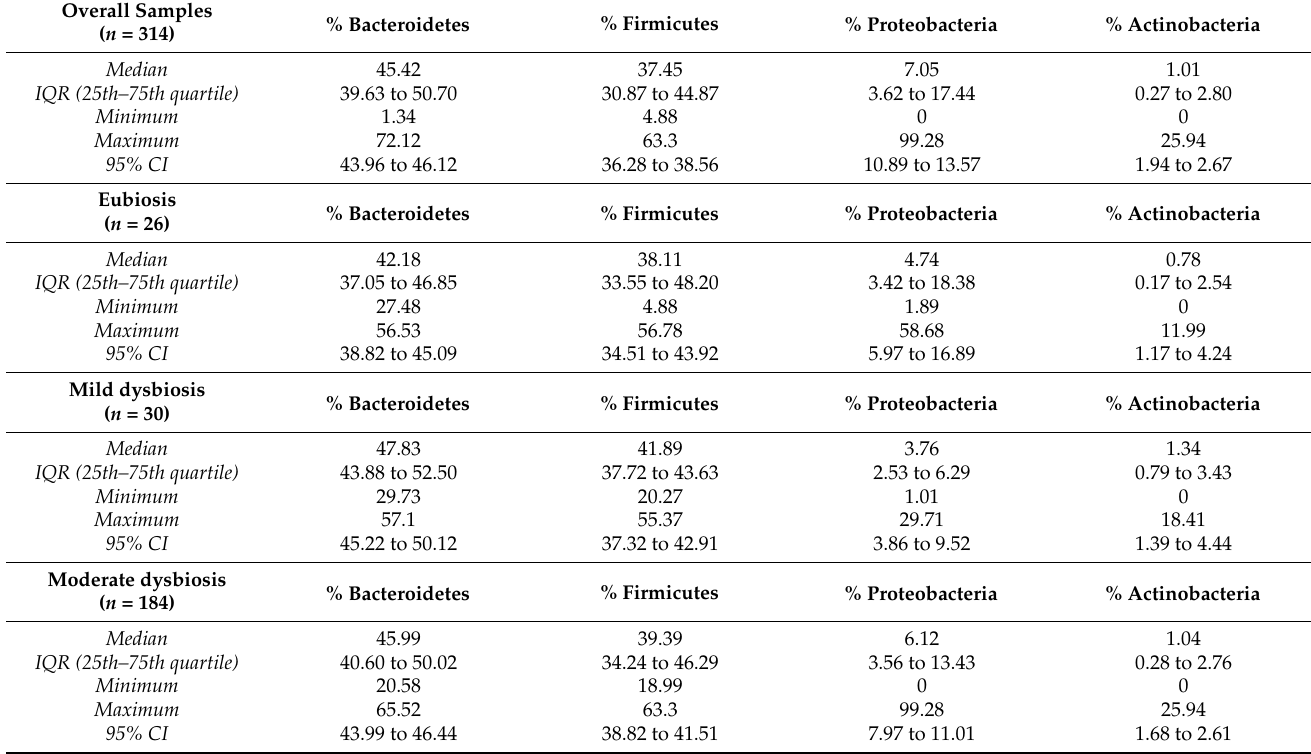
Table 3. Median values, IQR, 95% CI, and minimum and maximum value of the percentages of the Phyla detected for all the statuses